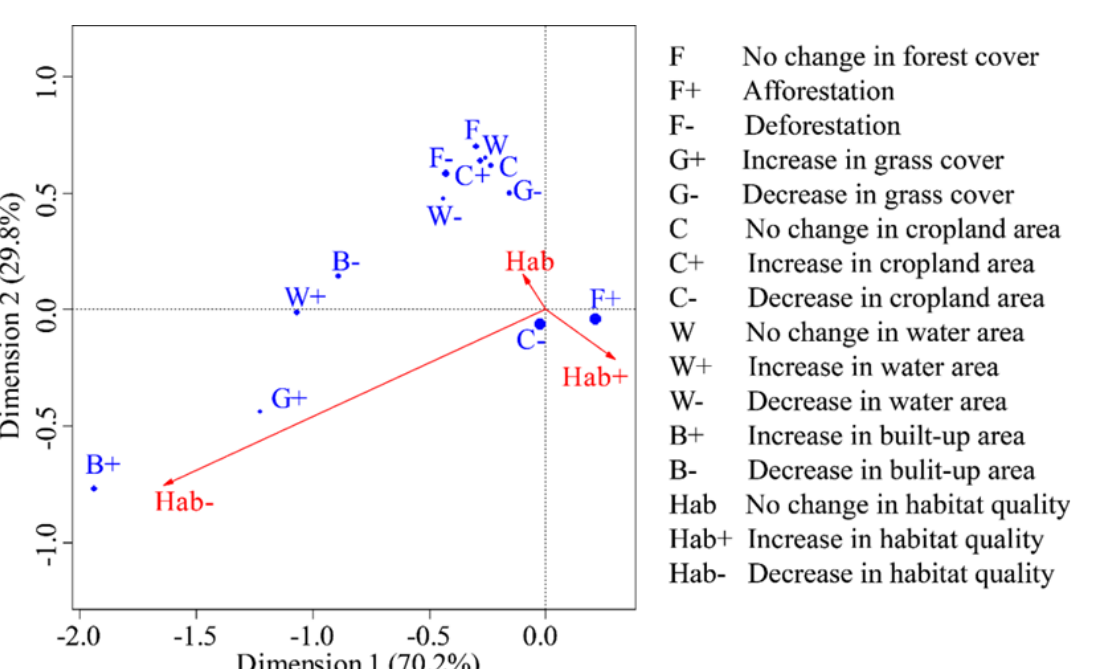
Figure 6. Heat map of correlation matrix and hierarchical clustering for 20 counties in the TGR area according to habitat quality.